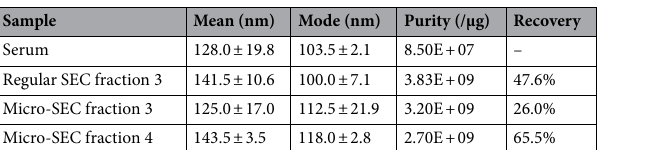
Figure 3. Micro-SEC method was developed for rapid serum EV isolation. ( a ) 25 uL pre-cleared and diluted serum sample was loaded on micro-SEC column and fractions were collected. ( b ) EV concentration was measured by NTA and protein content were assayed by OD660 (left). The purity of EV samples was calculated by particle/µg protein. CD63 Direct ELISA was used to measure the EV peak in all the fractions. All the data were collected from two individual columns.